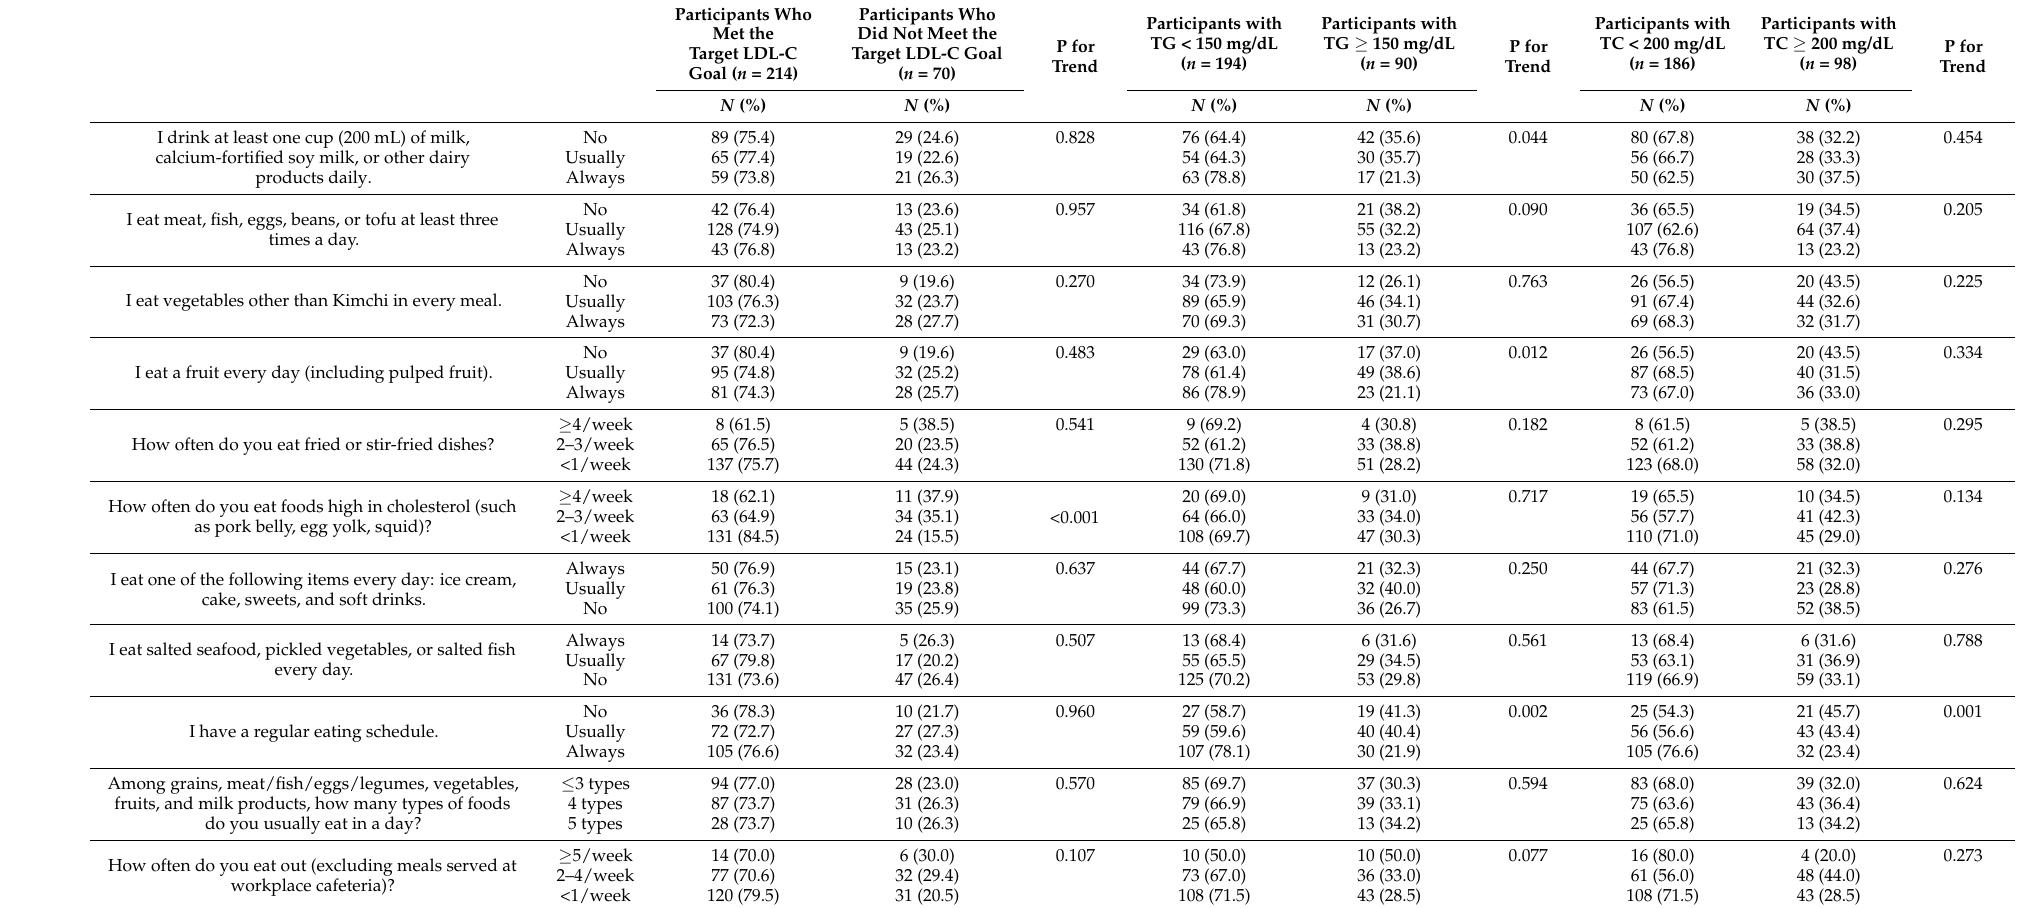
Table 2. Dietary habits and the control of LDL-C, TG, and TC at 6 months. Participants Who Met